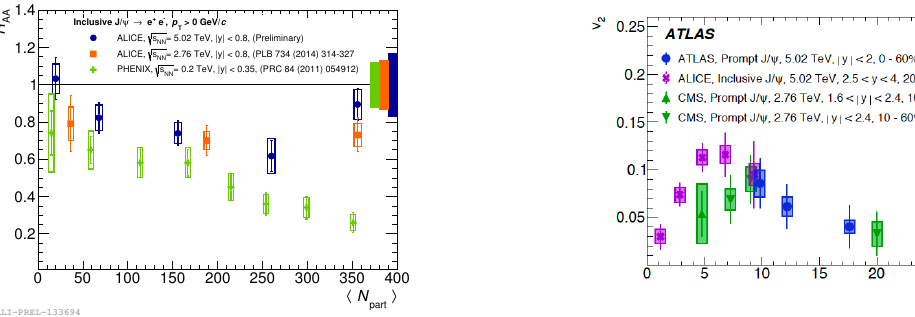
Figure 3. Left: Inclusive J/ Ψ R AA at mid-rapidity as a function of centrality as measured by PHENIX and ALICE. Right: Results for v 2 as a function of p T of prompt J/ Ψ as measured by ATLAS and CMS compared with inclusive J/ Ψ as measured by